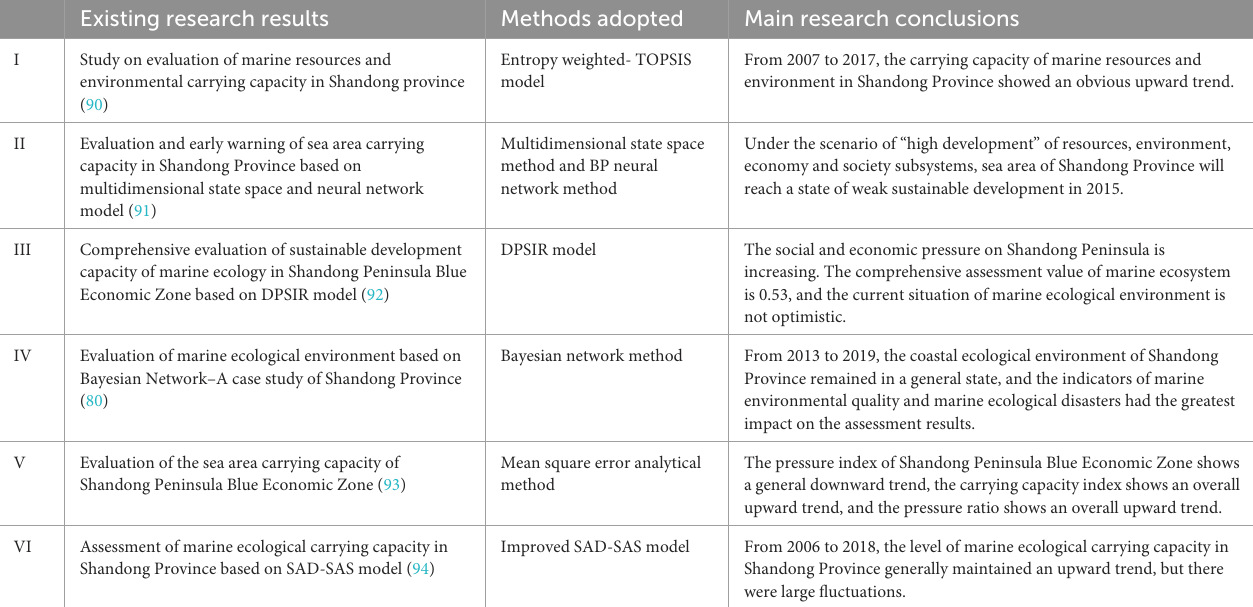
TABLE 10 Related research on marine ecological carrying capacity in Shandong